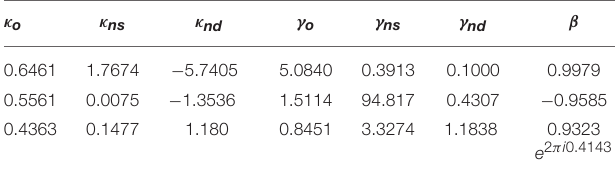
TABLE 7 | EOD-subadditivity paradigm: Optimized fit of Hamiltonian parameters under constraint β > 0 (RMSE (RMSE =